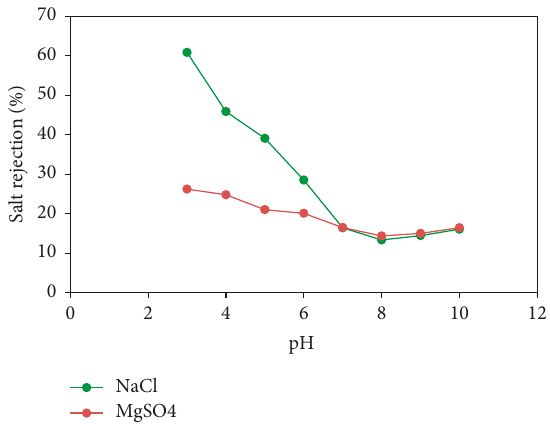
Figure 8: Effect of the pH on the rejection performance of the MWCNT/CHIT evaporative cast